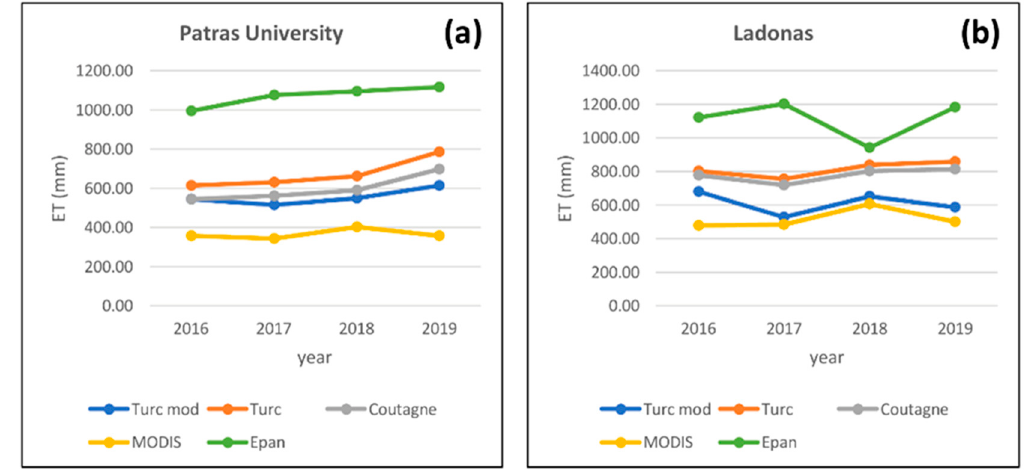
Figure 8. Annual ETa by empirical methods, MODIS ET, and Epan for 2016–2019: ( a ) Patras University station, ( b ) Ladonas station.